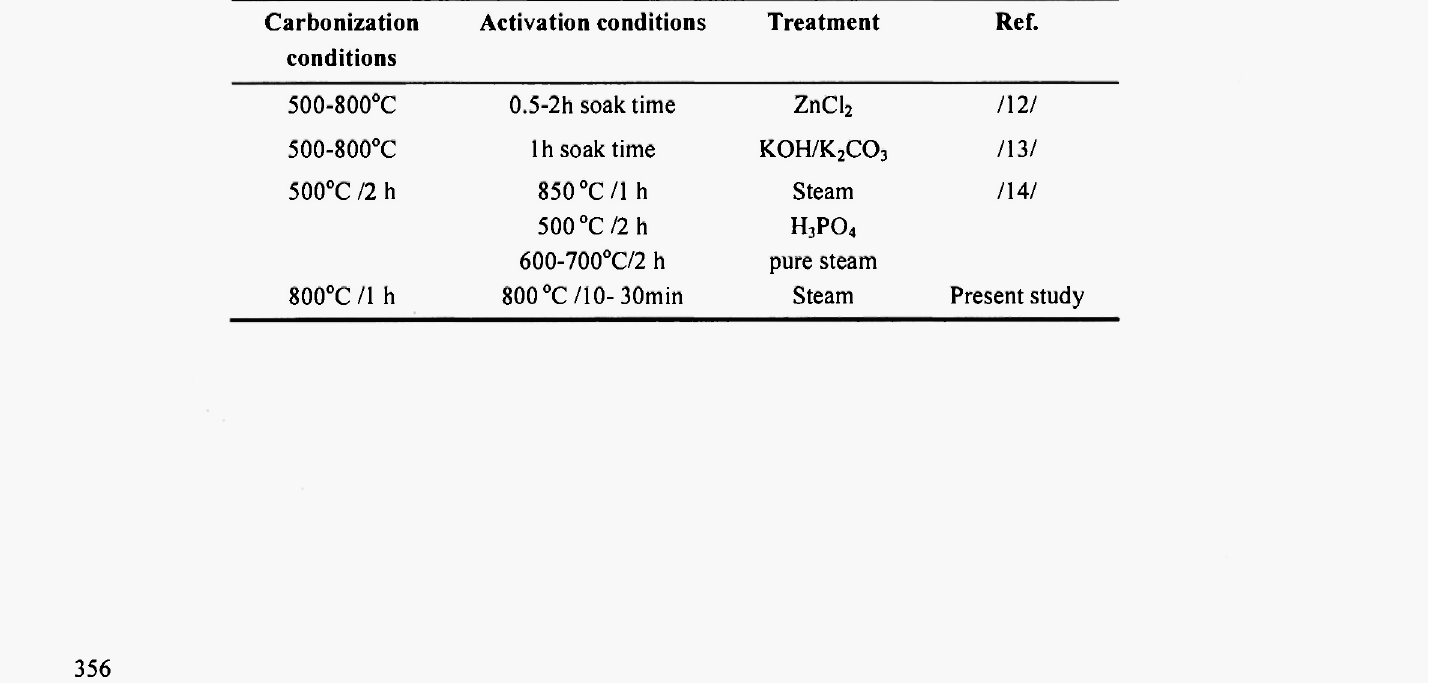
Carbonization and activation conditions of corn cob (Literature data and present